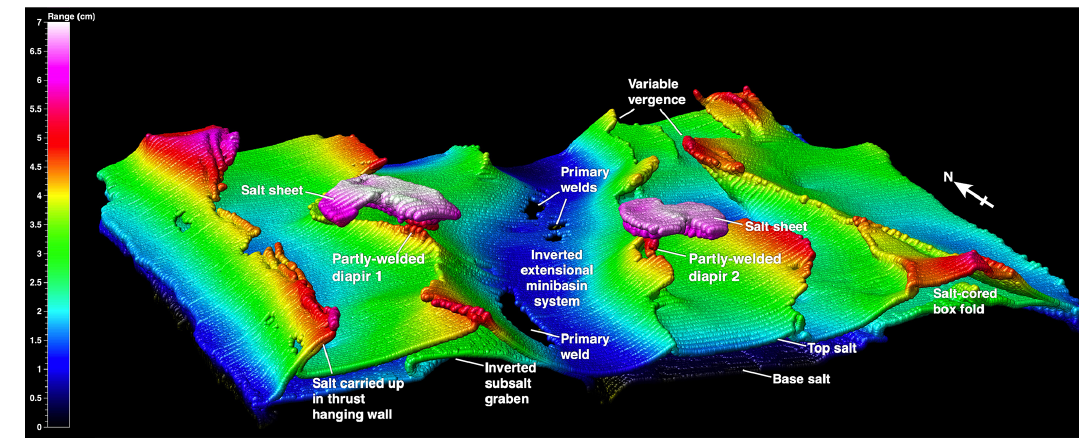
Figure 12. 3-D reconstruction of the salt volume from Model 1. See main text for